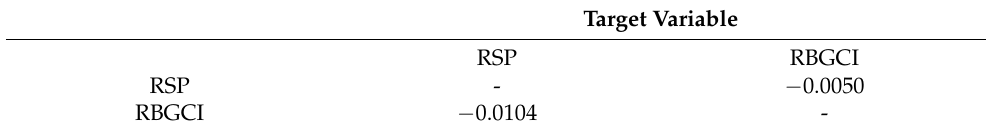
Table 5. Feature importance on returns.